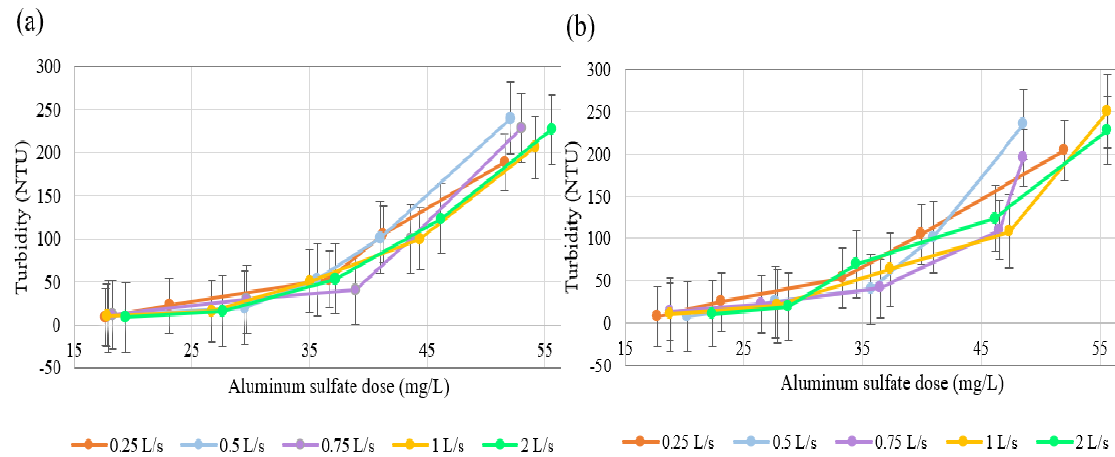
Figure 6. Dose of coagulant applied for ( a ) length of 68.4 m and ( b ) length of 97.6 m.